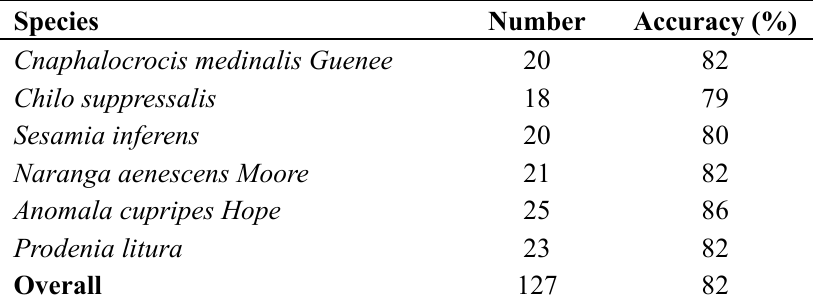
Table 3. Testing results for BP-ANN in the